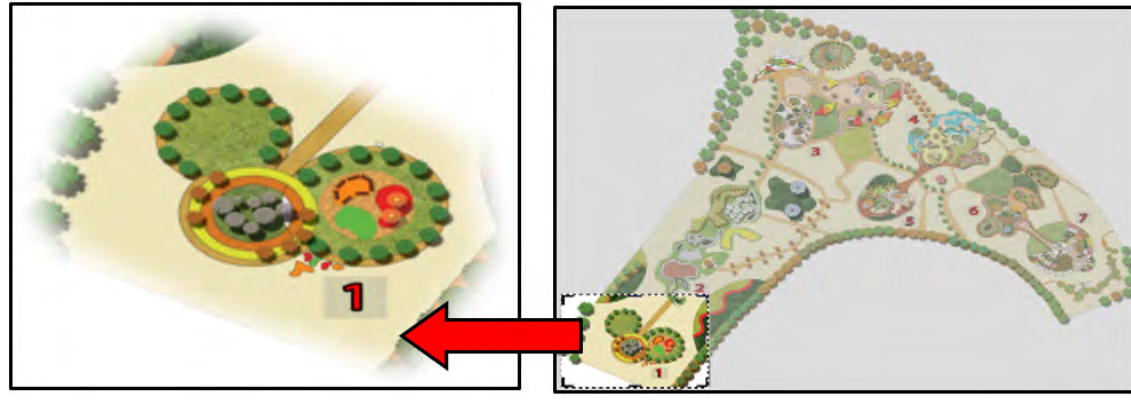
Figure 6. The location of entrance zone